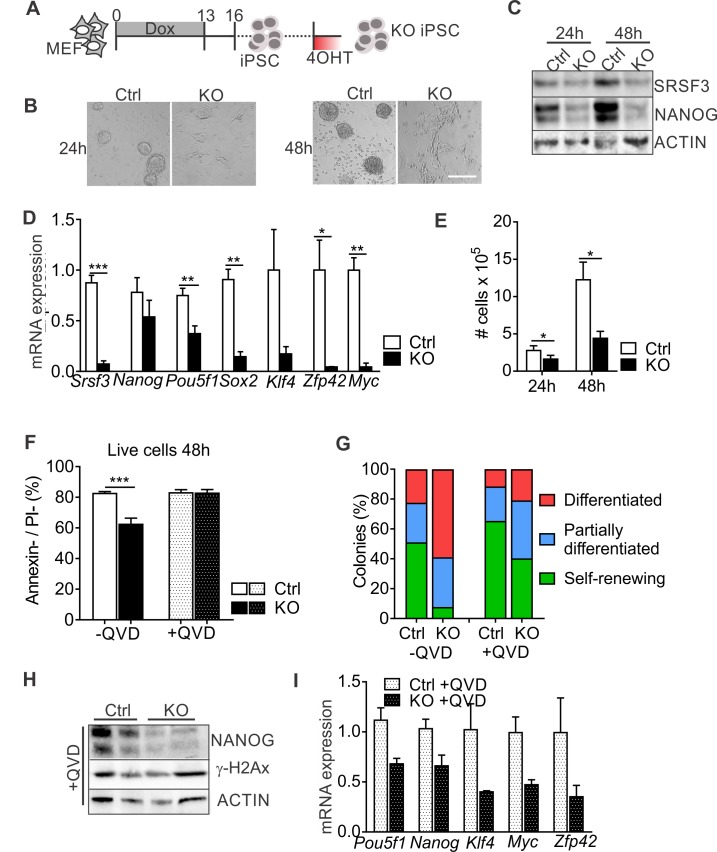
SRSF3 depletion leads to loss of pluripotency independent of cell death.(A) Experimental outline of the Srsf3-KO iPSC generation. (B) Phase contrast images of SRSF3 depleted (KO) and control (Ctrl) iPSCs 24 and 48 hr after 4OHT induction. Scale bar: 50 μm. (C) Western blot analysis of SRSF3 and NANOG expression in SRSF3 deficient (KO) and control (Ctrl) iPSCs 24 and 48 hr after 4OHT induction. ACTIN served as a loading control. (D) Quantification of Srsf3 and pluripotency marker mRNA expression in Srsf3-KO (KO) and control (Ctrl) iPSCs 24 hr after 4OHT induction. The data is normalised to Hprt and presented relative to control iPSCs (Unpaired Student’s t-test, two-tailed, *p<0.05, **p<0.01, ***p<0.001, data as mean ± SEM, n = 3). (E) Quantification of cell numbers 24 and 48 hr after 4OHT induction in Srsf3-KO (KO) and control (Ctrl) iPSCs (Unpaired Student’s t-test, two-tailed, *p<0.05, data as mean ± SEM, n = 4). (F) Quantification of live cells in untreated and QVD treated Srsf3-KO (KO) and control (Ctrl) iPSCs by AnnexinV/PI labelling and flow cytometry 48 hr after 4OHT induction (Unpaired Student’s t-test, two-tailed, *p<0.05, data as mean ± SEM, n = 3). (G) Quantification of pluripotent and differentiated iPSC colonies in untreated and QVD treated Srsf3-KO (KO) and control (Ctrl) iPSCs. Colonies were scored from three independent experiments. (H) Western blot analysis of γH2Ax and NANOG expression in QVD treated Srsf3-KO (KO) and control (Ctrl) iPSCs 48 hr after 4OHT induction. ACTIN served as a loading control. (I) Quantification of Srsf3 and pluripotency marker mRNA expression in QVD treated Srsf3-KO (KO) and control (Ctrl) iPSCs 24 hr after 4OHT induction. The data is normalised to Hprt and presented relative to control iPSCs (data as mean ± SEM, n = 2). See also Figure 2—figure supplement 1.